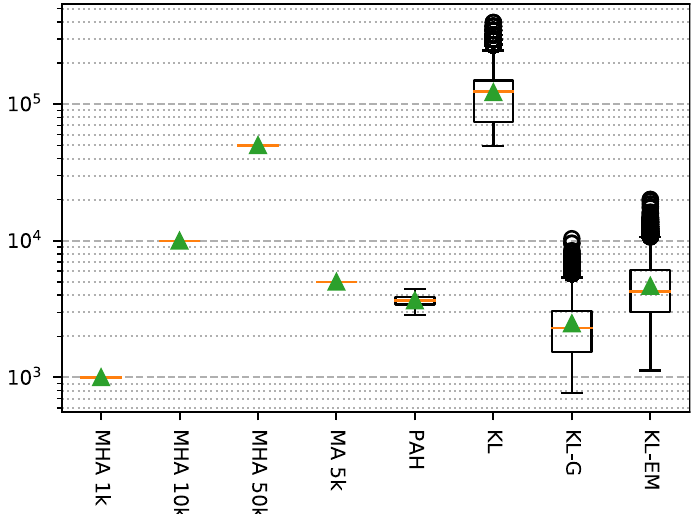
Fig 7. The recorded number of calculated deltas of the studied inference algorithm during all performed runs for Fig 4. The green triangle marks the mean and the orange line represents the median of the values.